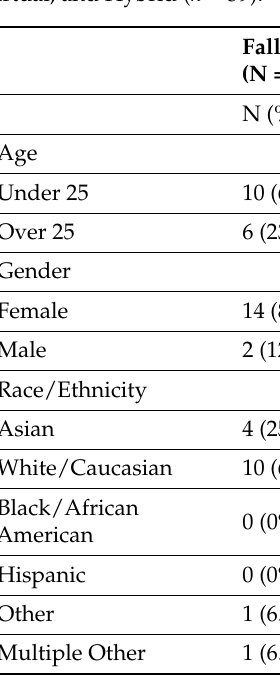
Table 1. Student Characteristics Post-Course across Three Semesters of PBT Course: In-Person, Virtual, and Hybrid ( n =